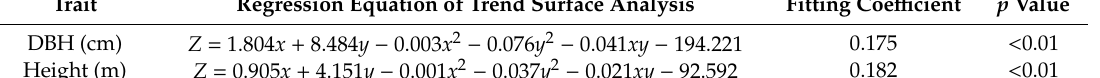
Table 3. Regression equations of the binary quadratic trend surface analysis fortreeheight and DBH. Trait Regression Equation of Trend Surface Analysis Fitting Coe ffi cient